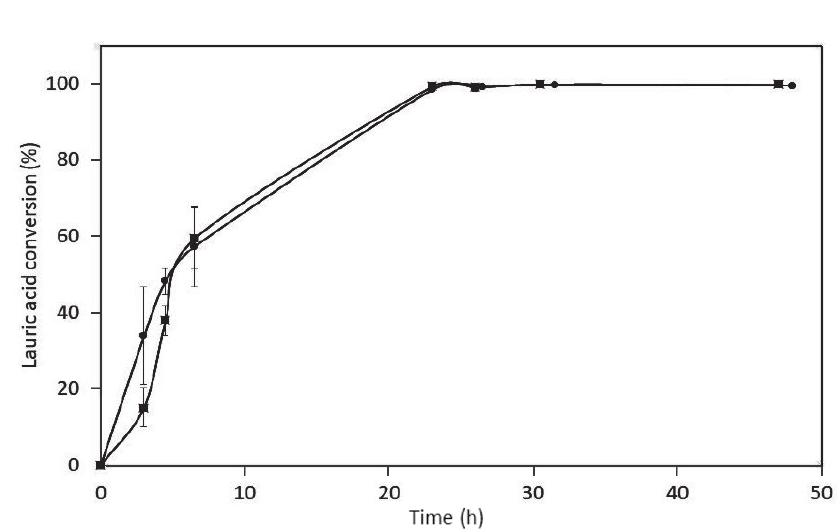
Fig. 3 – (a) Conversion of lauric acid and at 1:1 PG-10 and LA weight ratio (  ) In condition 2 and 3, extra molecular sieves (MS) (▲) and PG-10 (■) were added at 122 h. In condition 4, only extra MS (●) was added at 170 h. (b) Represents the acid values in these 4 conditions.